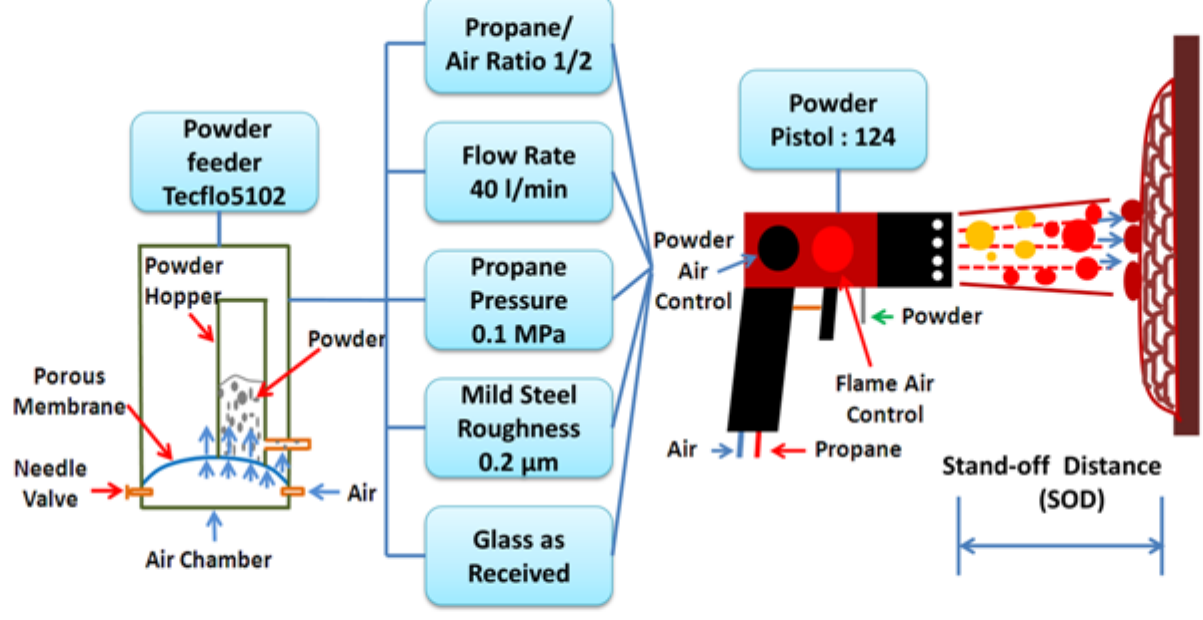
Figure 1. Schematic of flame spray that indicates variables that are associated with the